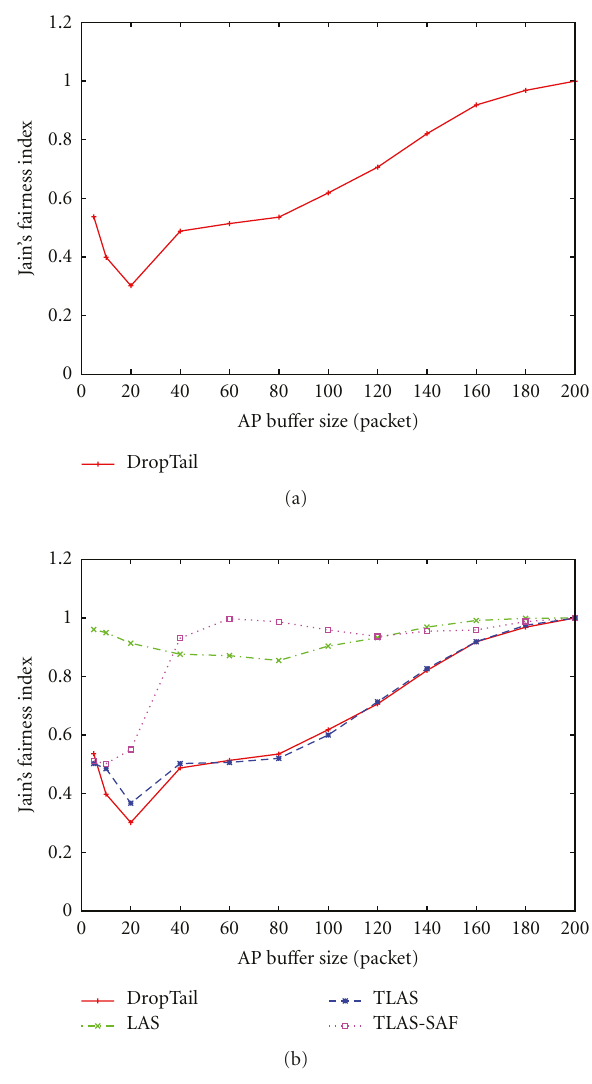
Figure 10: Jain’s fairness index: (a) DropTail/FIFO. (b) TLAS-SAF and other